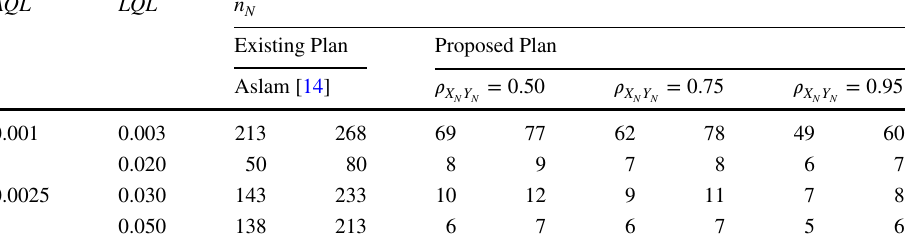
Table 11 Comparison with Aslam [14]